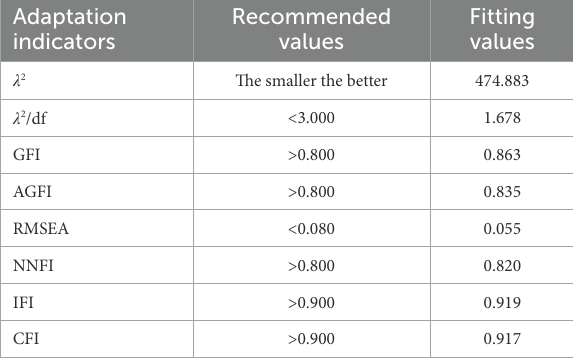
TABLE 7 Structural model adaptation